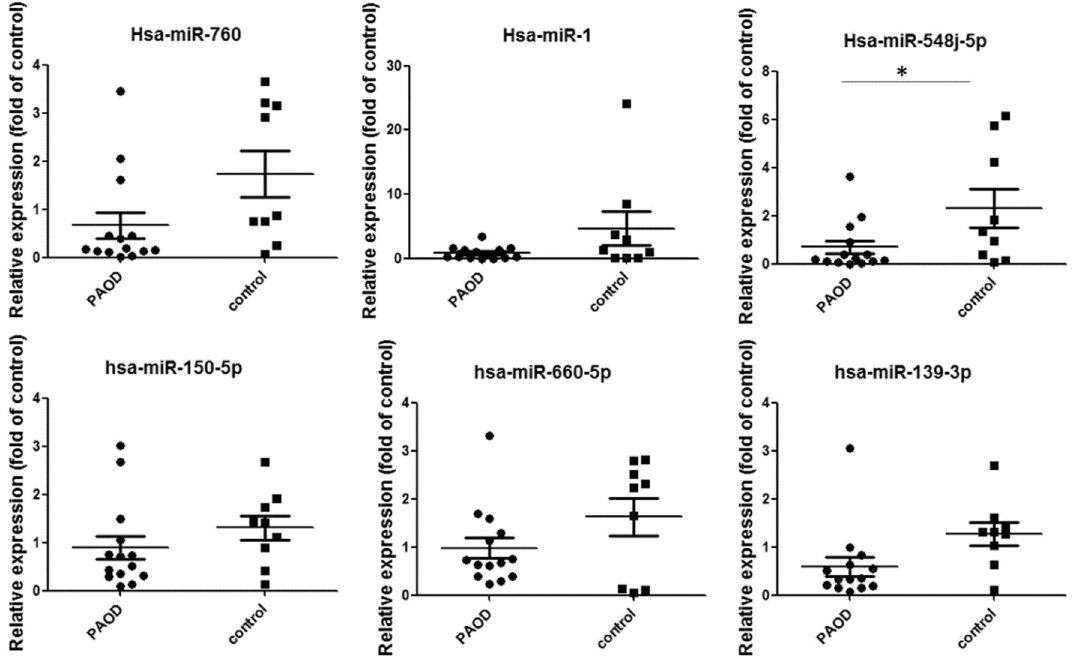
Figure 1. Expressions of microRNAs in patients with PAD as compared with the control group. Candidate miRNAs in the PAD group and the control group were analyzed. miR-548j-5p was significantly decreased in patients in the PAD group as compared with the controls (* P < 0.05 vs. control